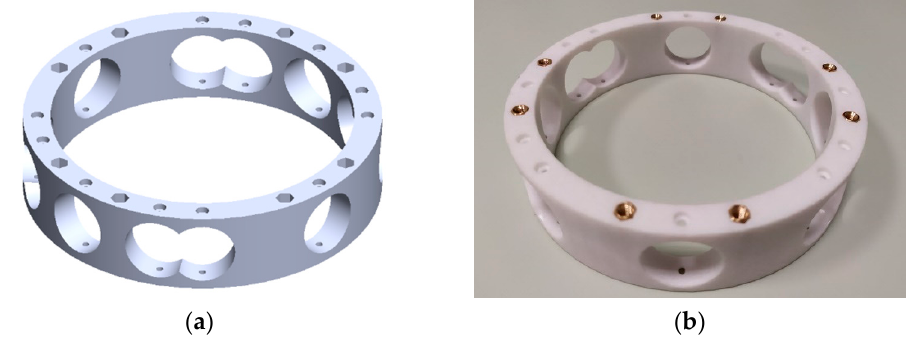
Figure 10. Propulsion center inner ring: ( a ) CAD model; ( b ) manufactured assembly.